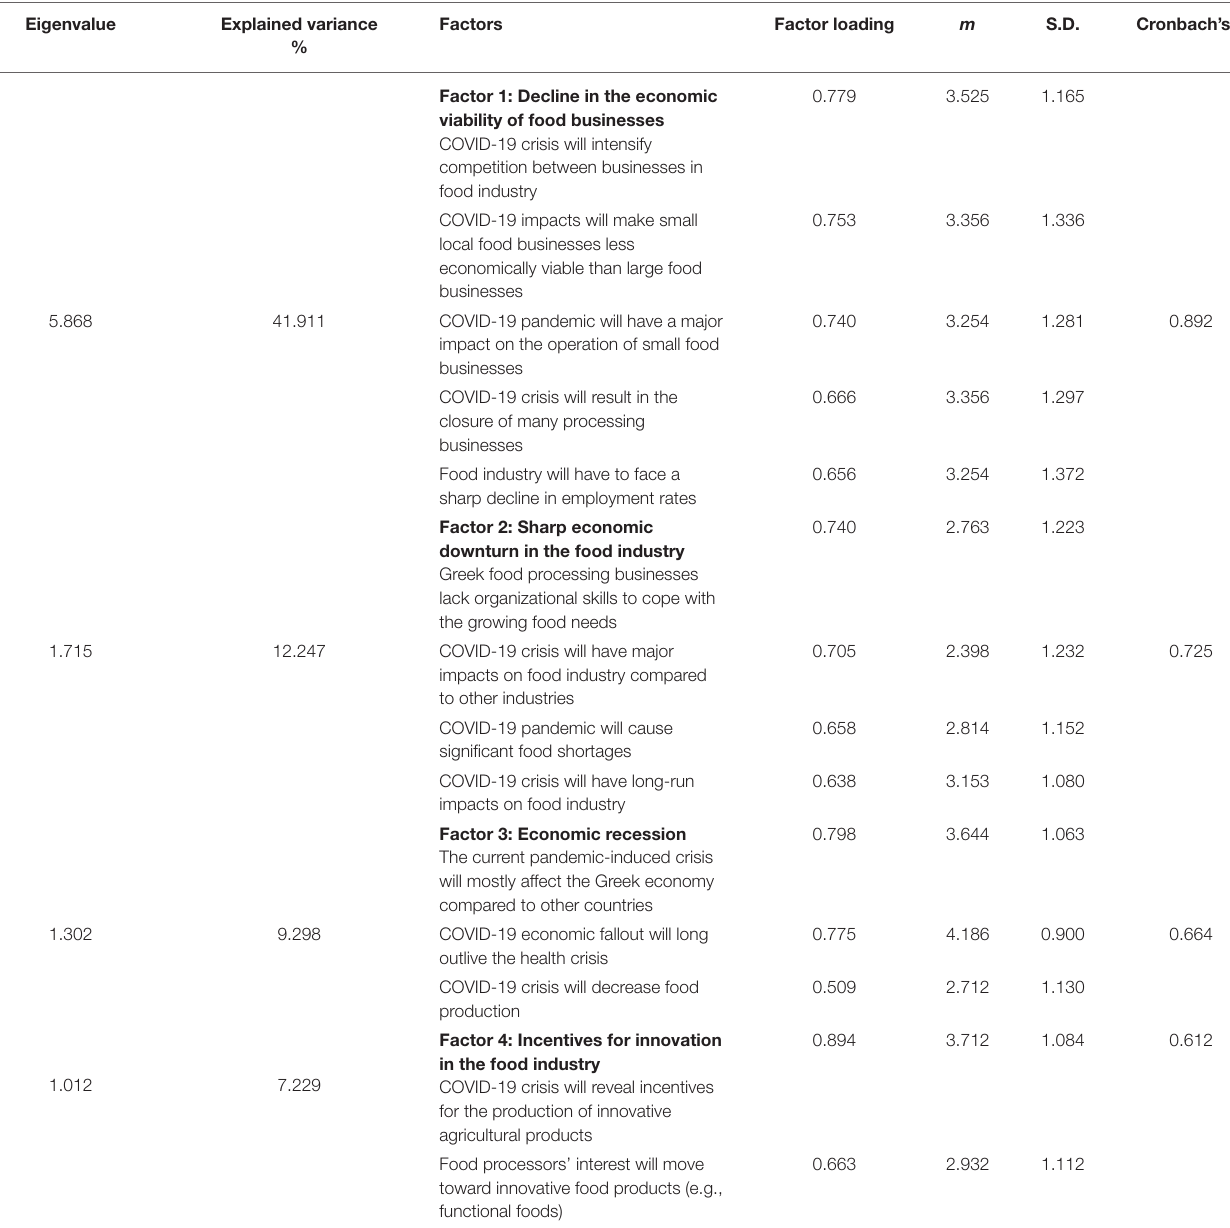
TABLE 5 | Factor analysis (PCA) and reliability analysis output on experts’ perceptions toward the impact of COVID-19 crisis on food production and food industry.